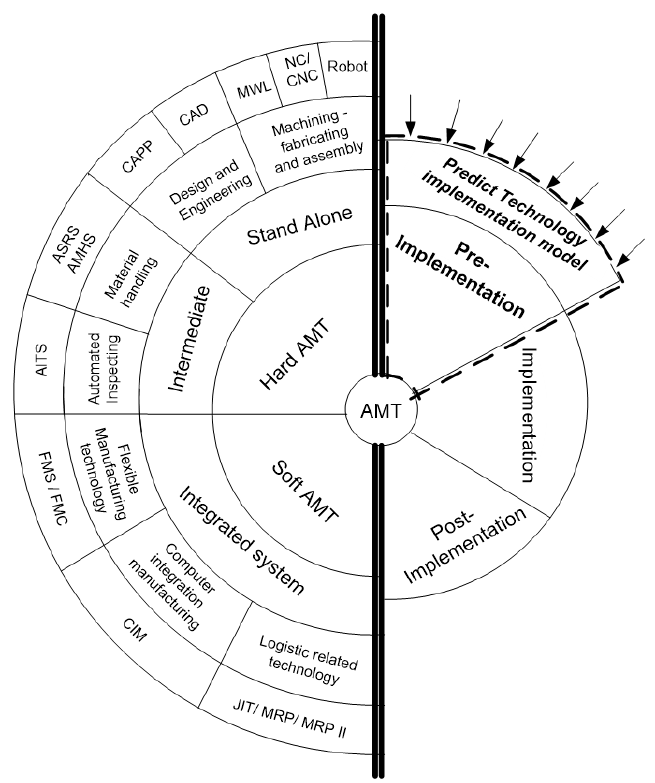
Figure 1. Classification of various advanced manufacturing technologies.